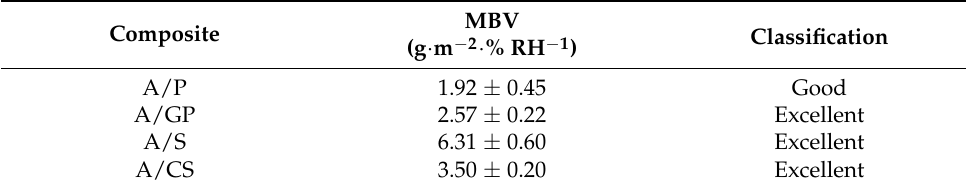
Figure 6. Moisture absorption cycle and desorption of the four composites during the cyclic variation of the relative moisture. Table 4. Value of the average MBV over the last three cycles and classification according to the Nordtest project (mean ±